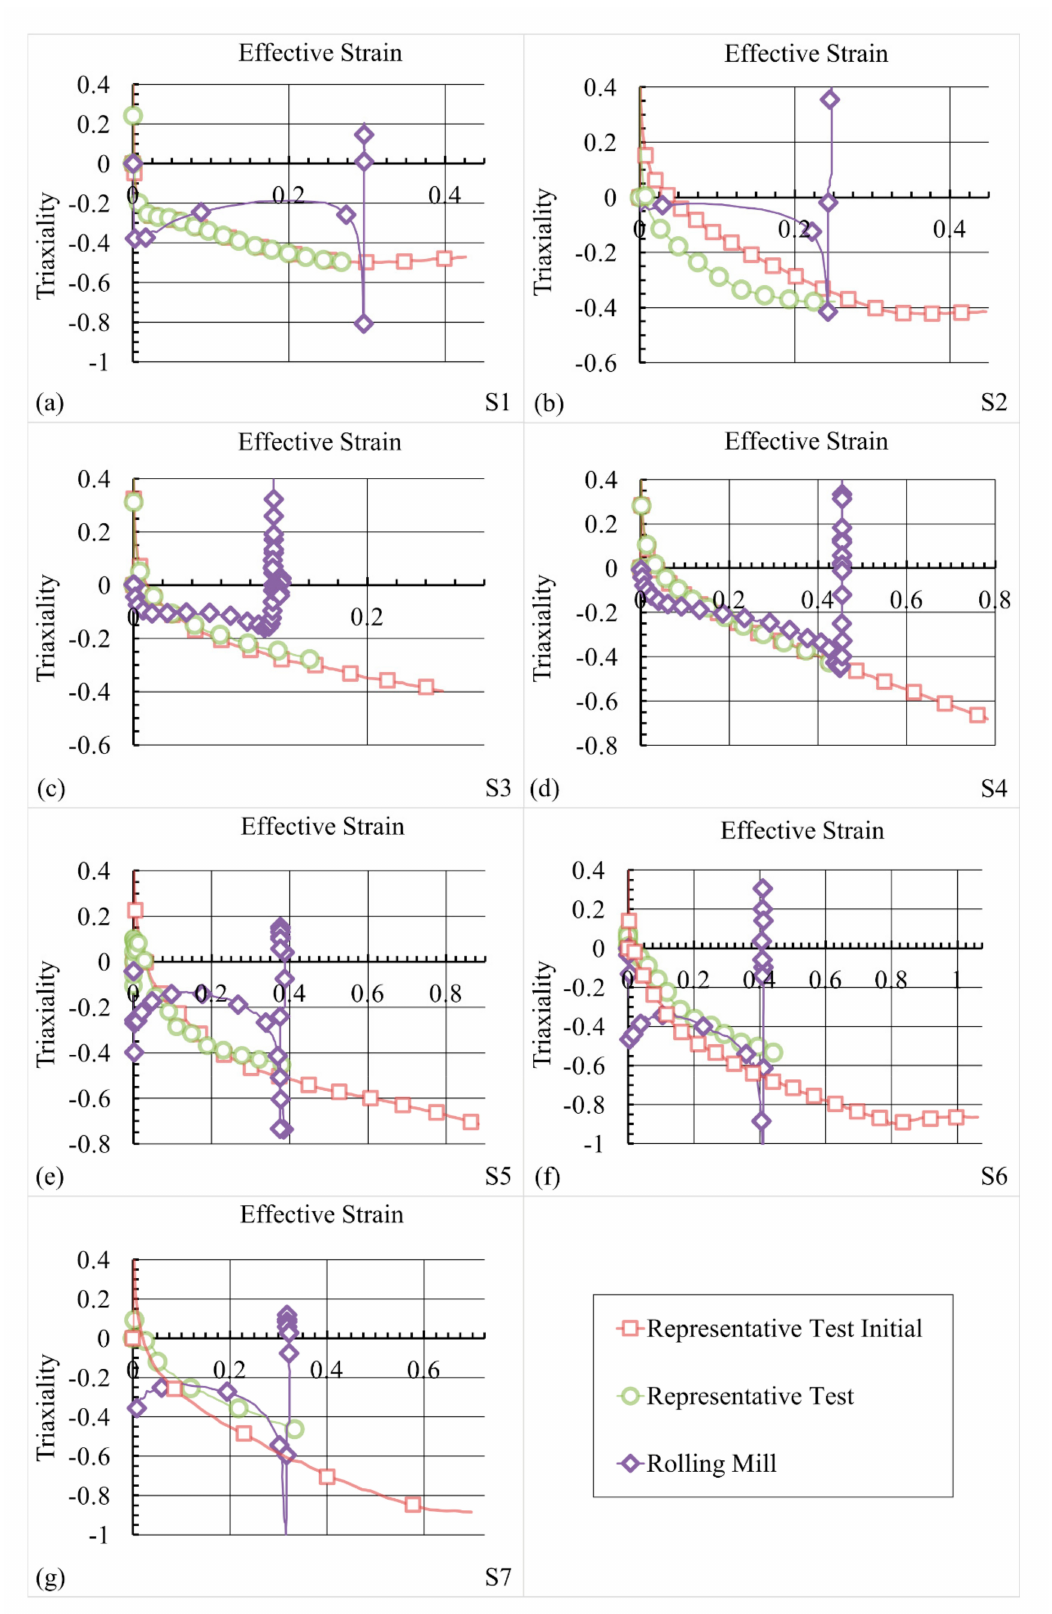
Figure 11. Triaxiality comparison between the initial representative test, the corrected representative test, and the rolling mill for ( a ) stand 1, ( b ) stand 2, ( c ) stand 3, ( d ) stand 4, ( e ) stand 5 ( f ) stand 6 and ( g ) stand 7 of